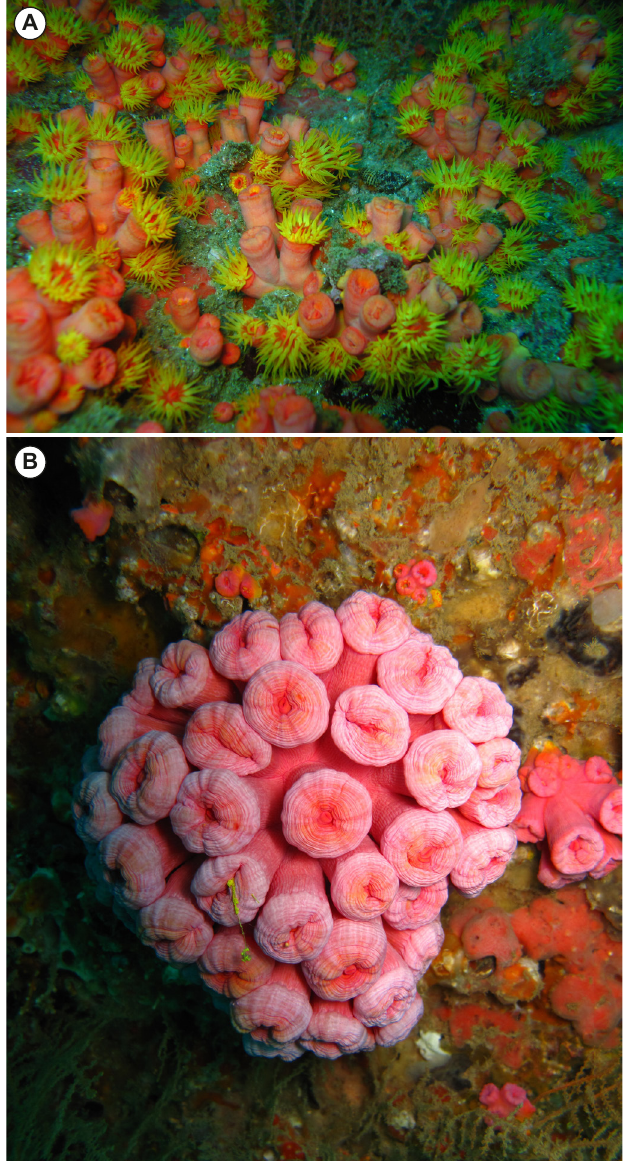
Tubastraea tagusensis